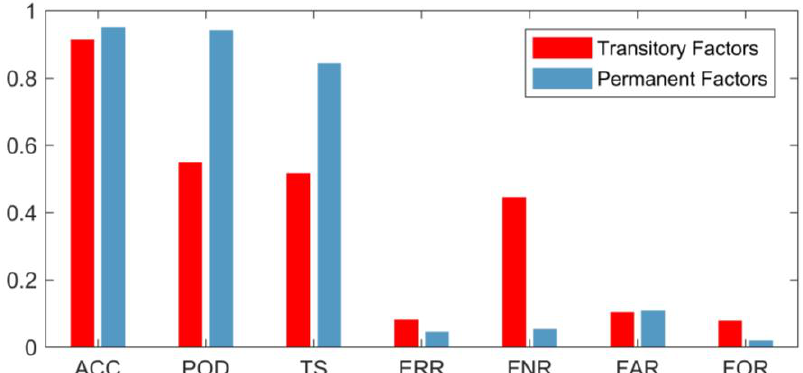
Figure 14. Predictive analytics of flood susceptibility maps based on transitory factors (red bars) and based on permanent factors (blue